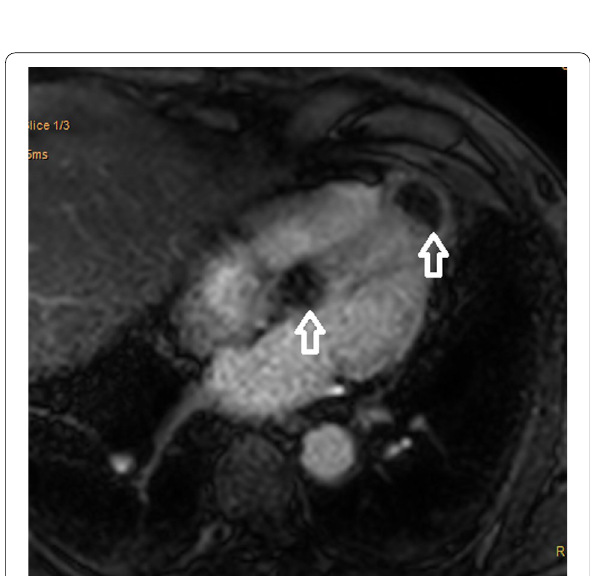
Fig. 3 Cardiac Magnetic Resonance Imaging: First pass perfusion in 4-chamber view demonstrating hypoperfusion of the lesions (indicated by arrows) when compared to normal